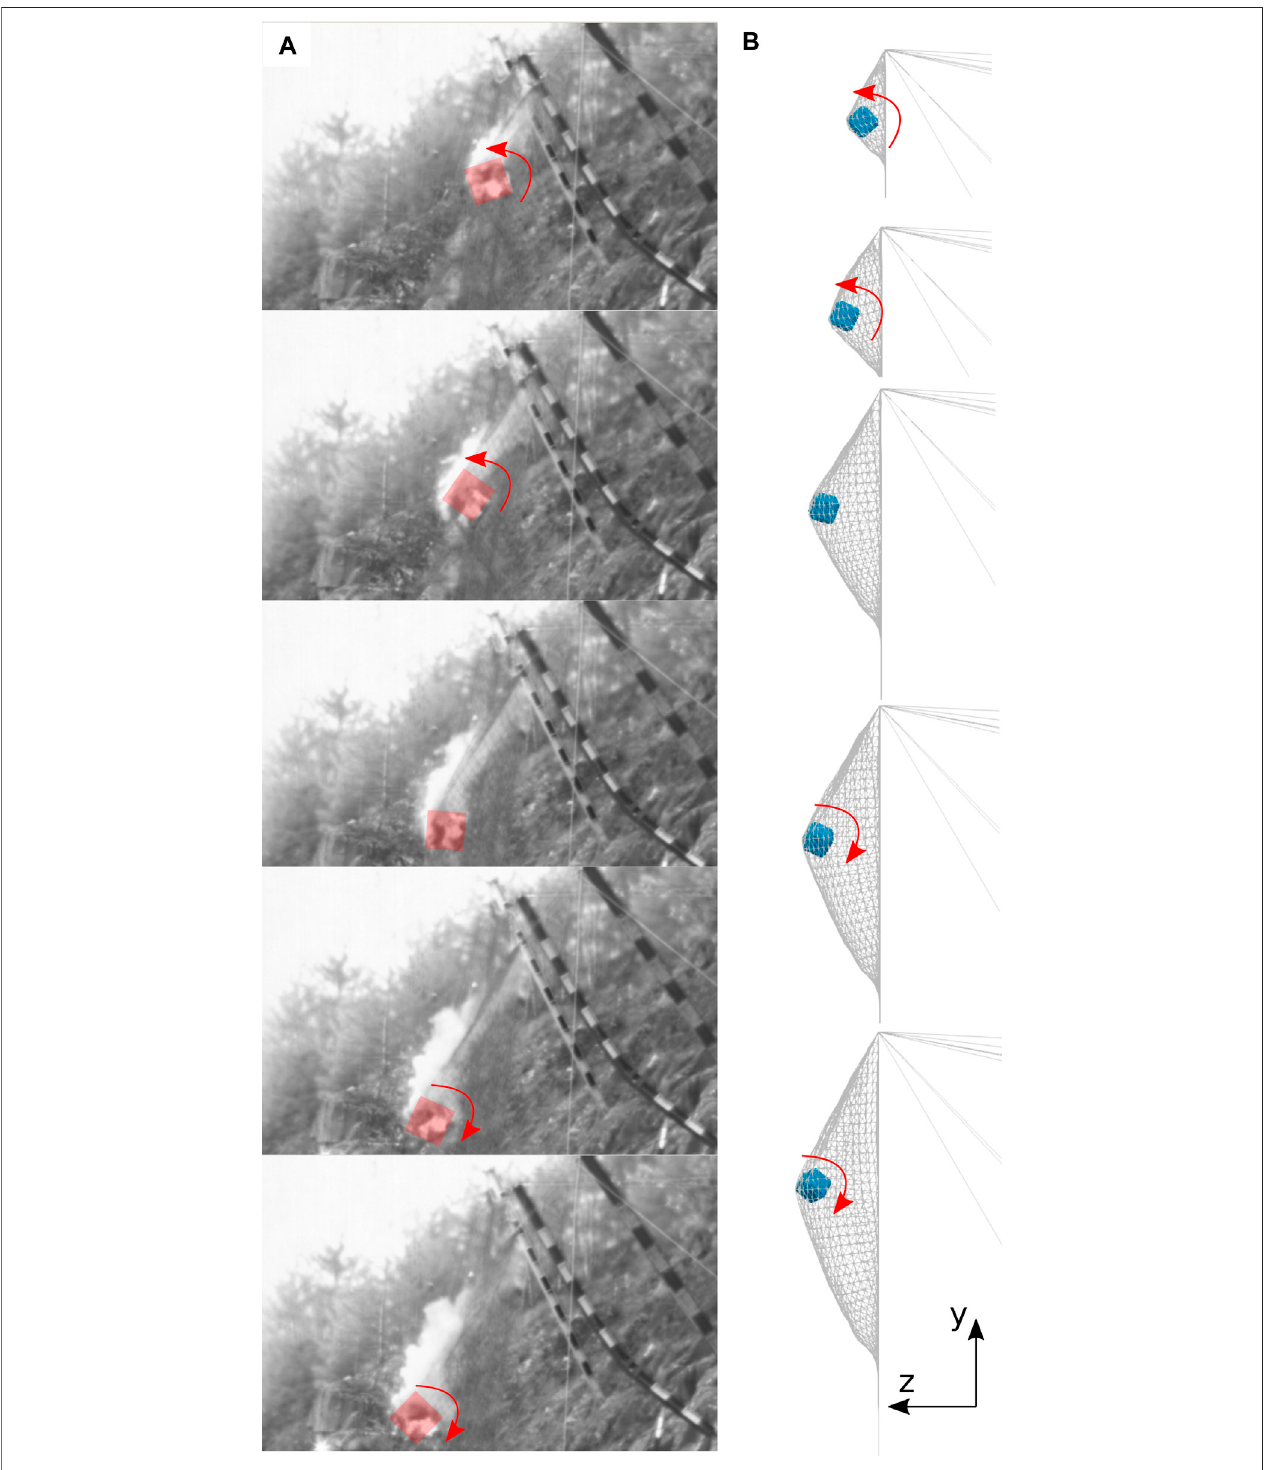
FIGURE 13 | The test object impacts with a certain angular velocity, stops rotating, slides for a short time period and starts rotating in the opposite direction subsequently. (A) Photos from the experiment. (B) Simulation.